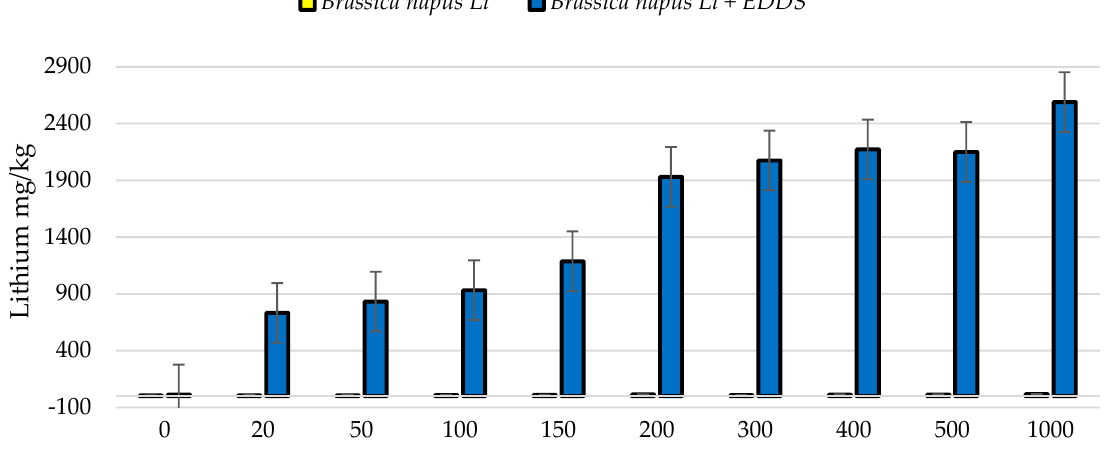
Figure 6. x ̅ Li concentration in leaves of Brassica napus from trial 1 (No chelator) and Brassica napus from trial 3 (EDDS treatments at 0.05M) X-axis, concentration of Li amended to the soil. (Units in mg/kg).